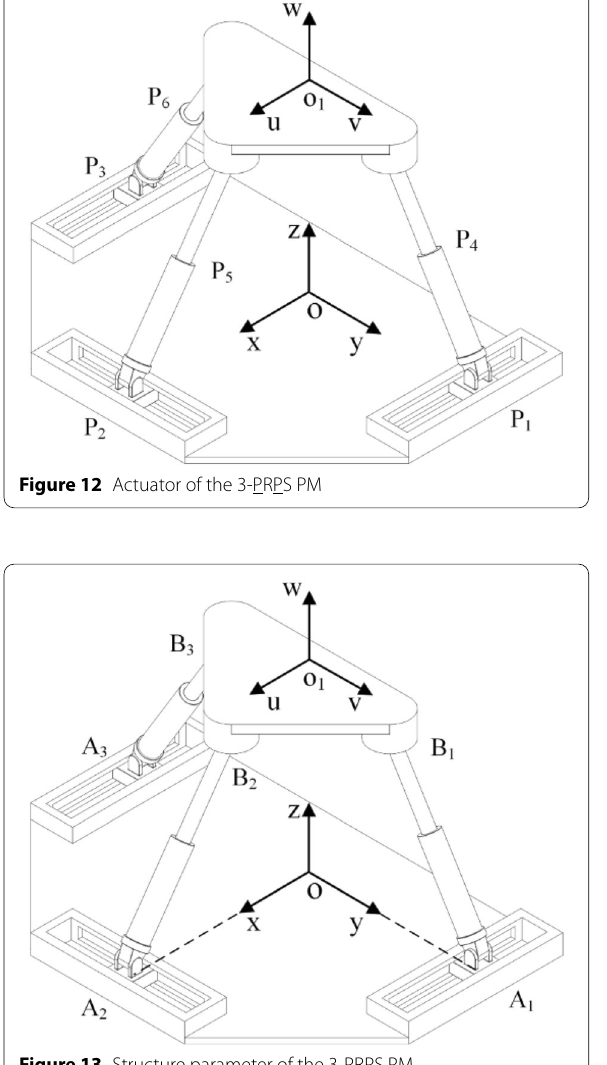
Figure 13 Structure parameter of the 3-PRPS PM